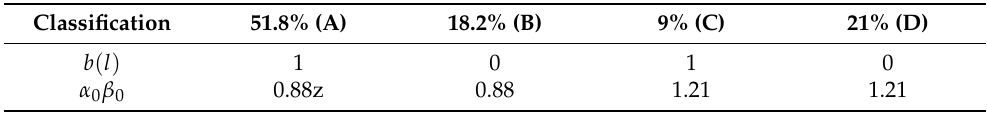
Table 2. Classification of EV